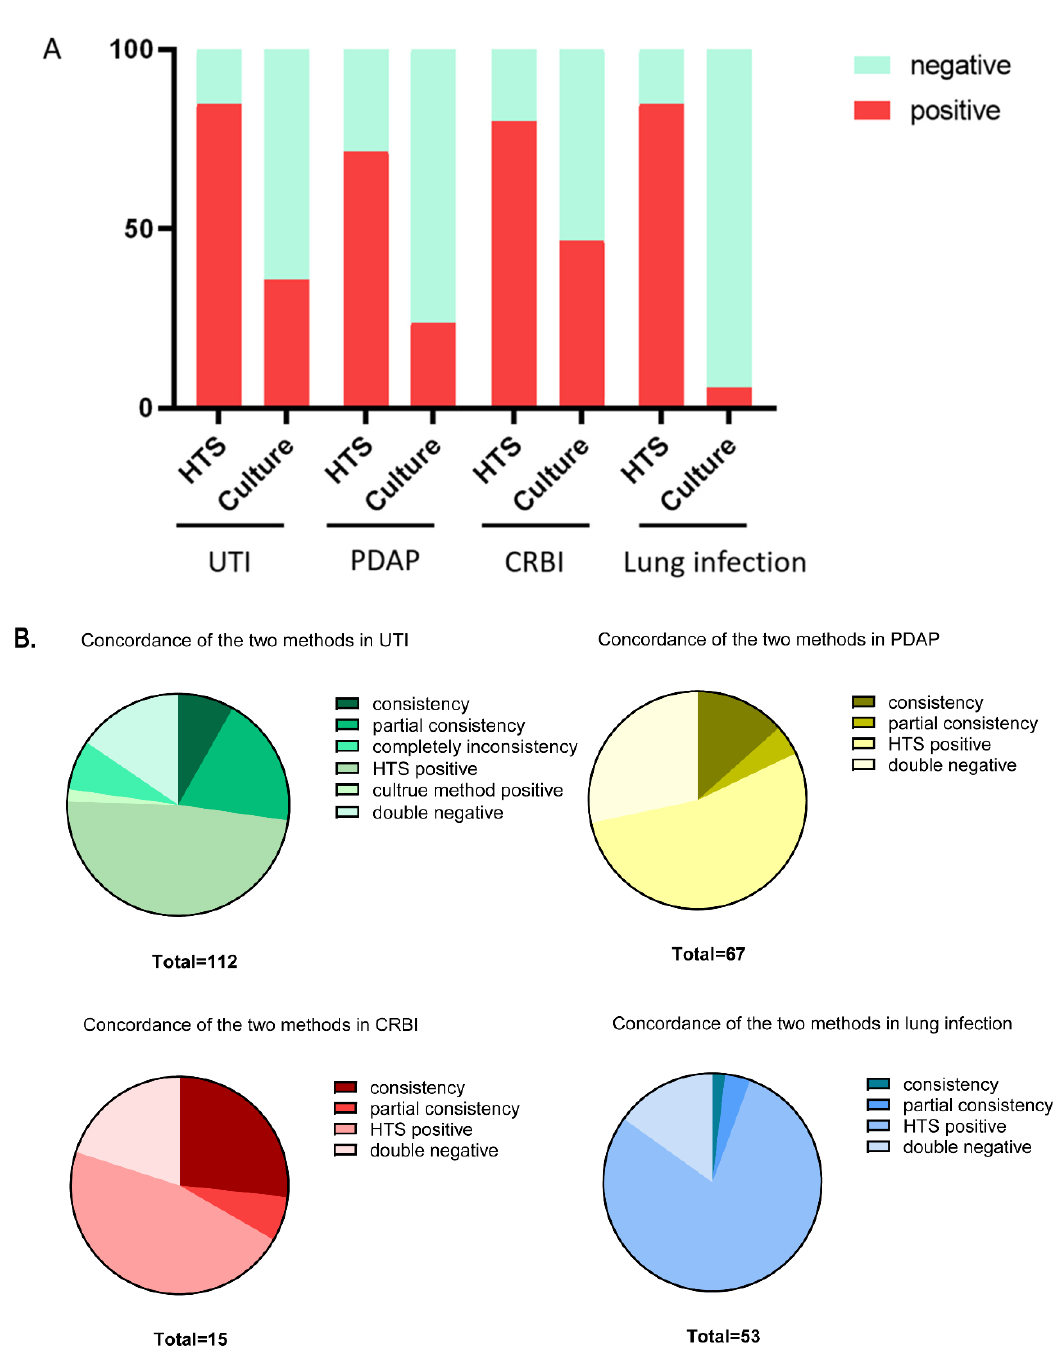
Figure 1. Profile of the detection results using HTS and culture methods on indicated infectious diseases. ( A ) Comparison of positive rate of detection between HTS and culture method. ( B ) Profile of detection results of the two methods in each infectious disease. Table 2. Comparison of positive rate of detection between HTS and culture methods.